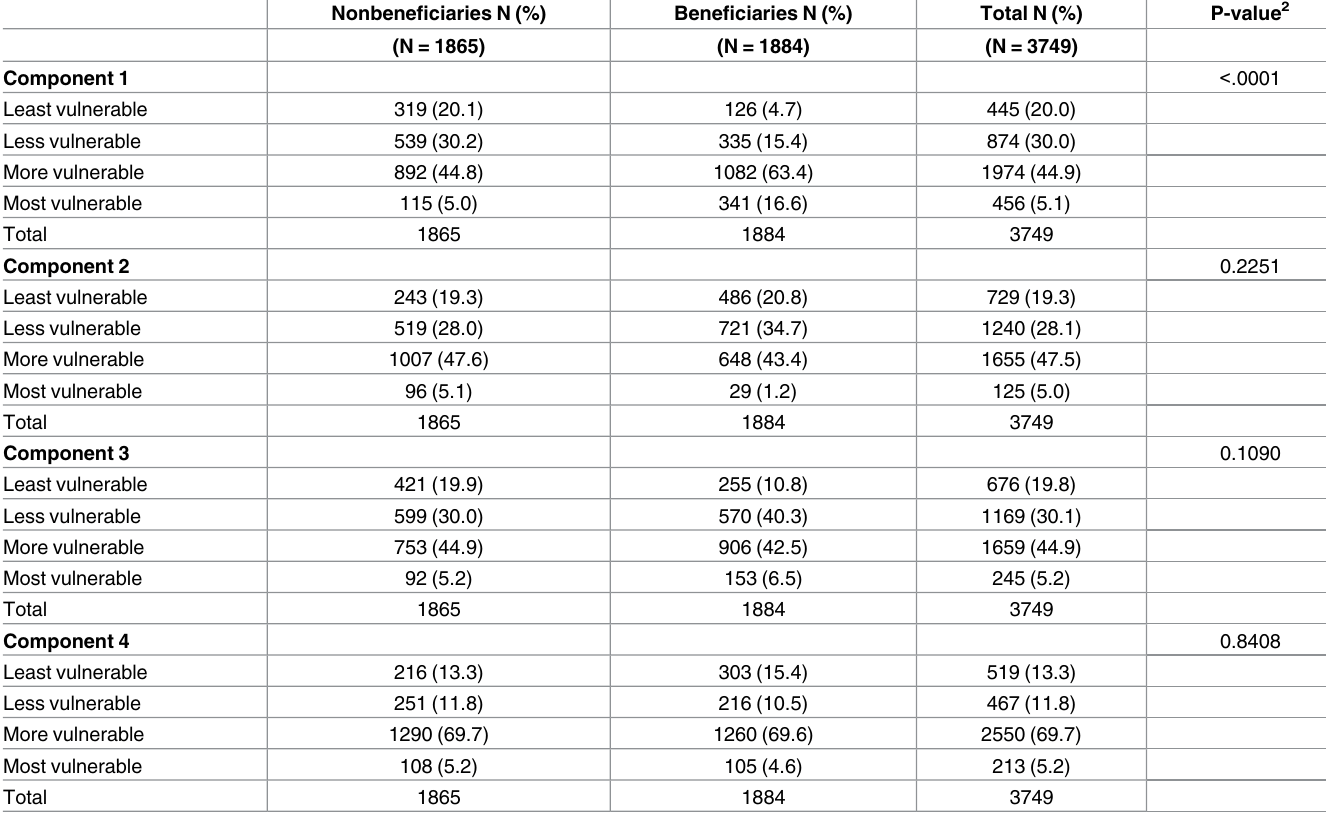
Table 5. Vulnerability distribution of components by beneficiary status.